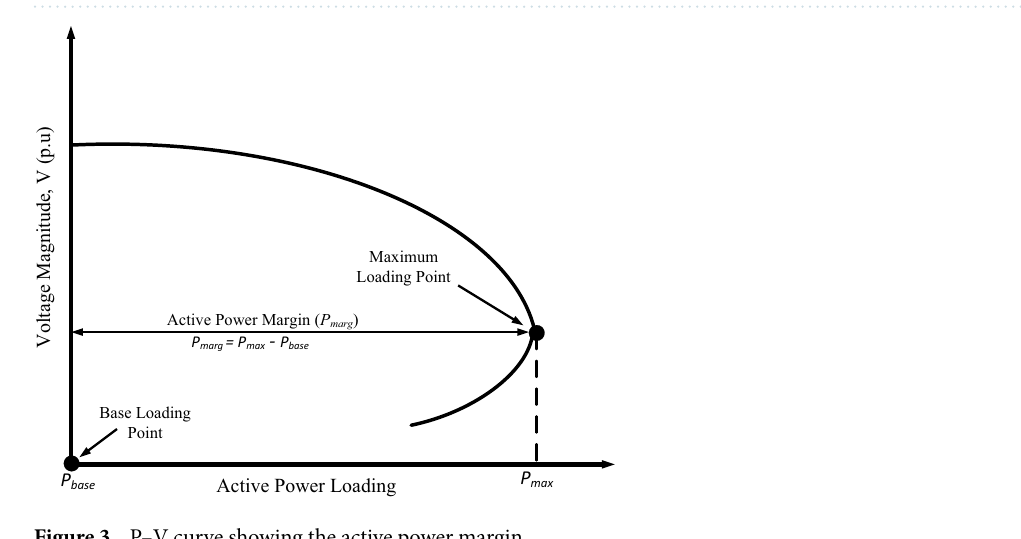
Figure 2. World solar energy map 55 .